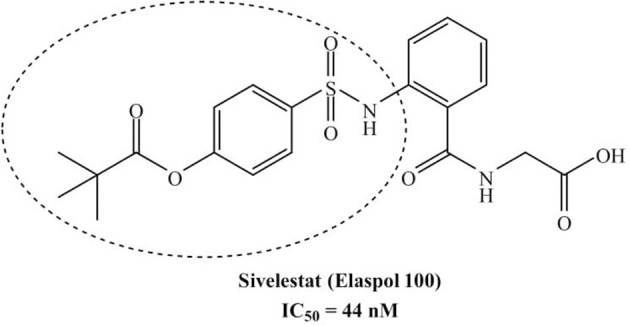
Sivelestat (ONO-5046) claimed by Ono Pharmaceutical (Kawabata et al., 1991).